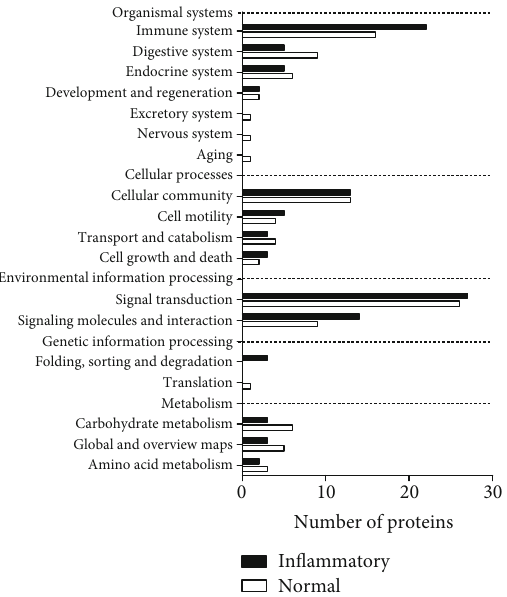
Figure 4: Kyoto Encyclopedia of Genes and Genomes ( KEGG) pathway analysis of the commonly secreted proteins by all mesenchymal stem cells (MSCs) under normal and in fl ammatory